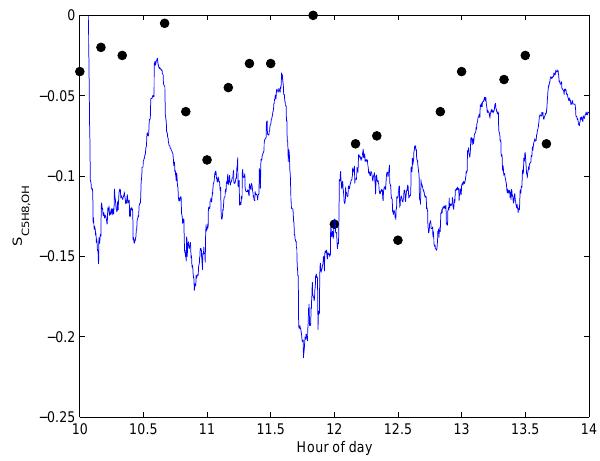
Fig. 4. Comparison of the observed S C (black dots), with the model estimate using the approach described in this paper ( t s =10min) (blue